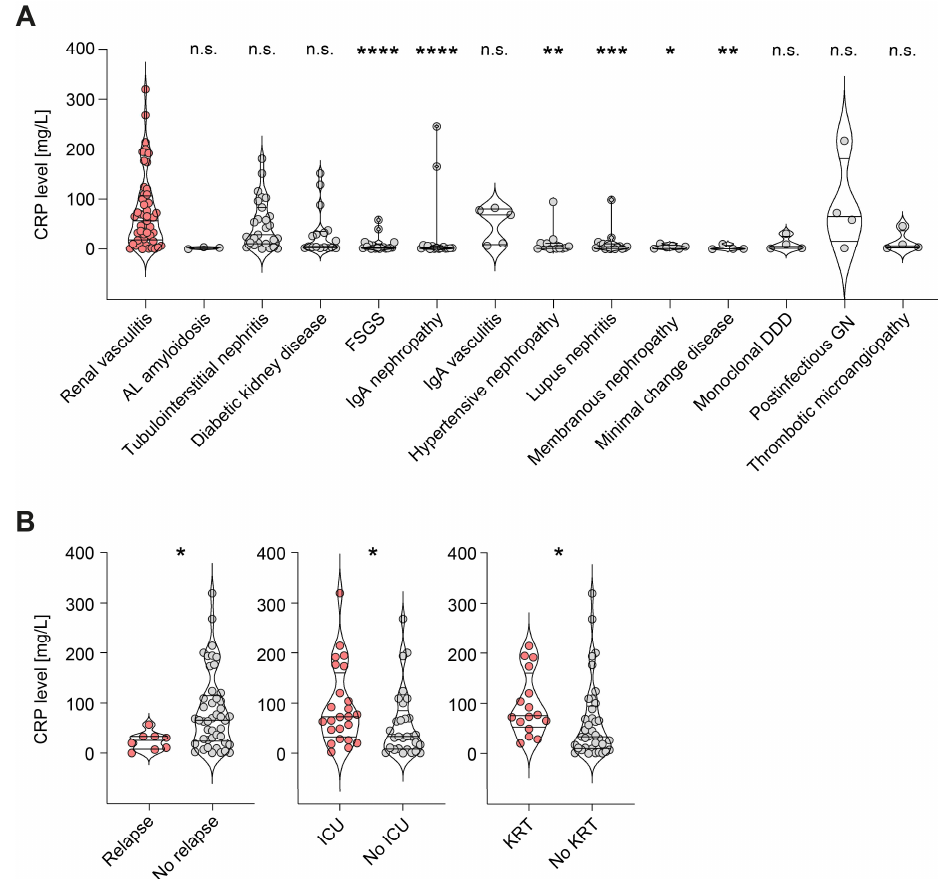
Figure 1. CRP elevation is associated with active ANCA-associated renal vasculitis: ( A ) Violin plots and individual data points for CRP levels are shown in renal vasculitis (n = 53) and disease controls, including AL amyloidosis (n = 3), tubulointerstitial nephritis (n = 27), diabetic kidney disease (n = 17), FSGS (n = 18), IgA nephropathy (n = 17), IgA vasculitis (n = 5), hypertensive nephropathy (n = 13), lupus nephritis (n = 16), membranous nephropathy (n = 6), minimal change disease (n = 4), monoclonal DDD (n = 4), post-infectious GN (n = 4), and thrombotic microangiopathy (n = 4). The Kruskal–Wallis test with Dunn’s multiple correction was performed for group comparisons (n.s. = not significant, * p < 0.05, ** p < 0.01, *** p < 0.001, **** p < 0.0001). ( B ) CRP levels after